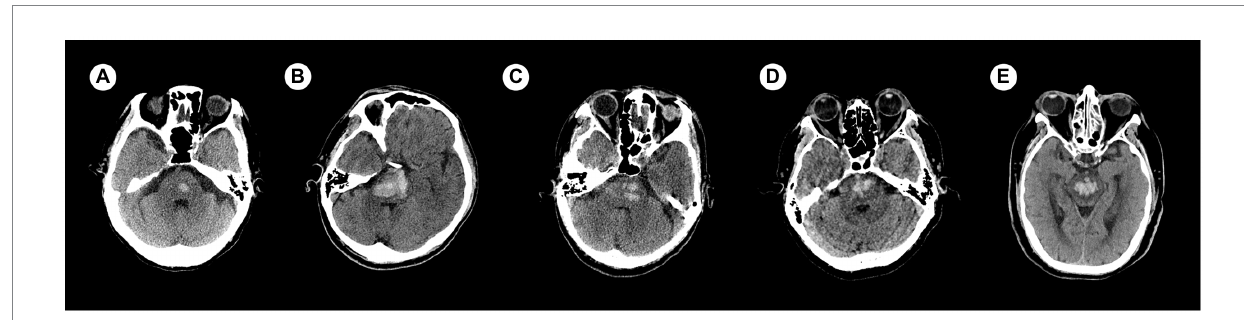
FIGURE 4 Examples of categories based on hematoma shape and density. (A) Category I-I (shape I—density I). (B) Category II-II (shape II—density II). (C) Category III–III (shape III—density III). (D) Category IV–IV (shape IV—density IV). (E) Category V–V (shape V—density V). The categories of I and II were defined as regular/homogeneous while the categories of III to V were defined as